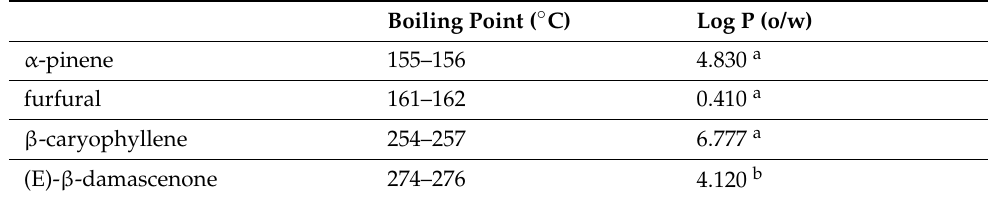
Table 3. Selected properties of the four studied